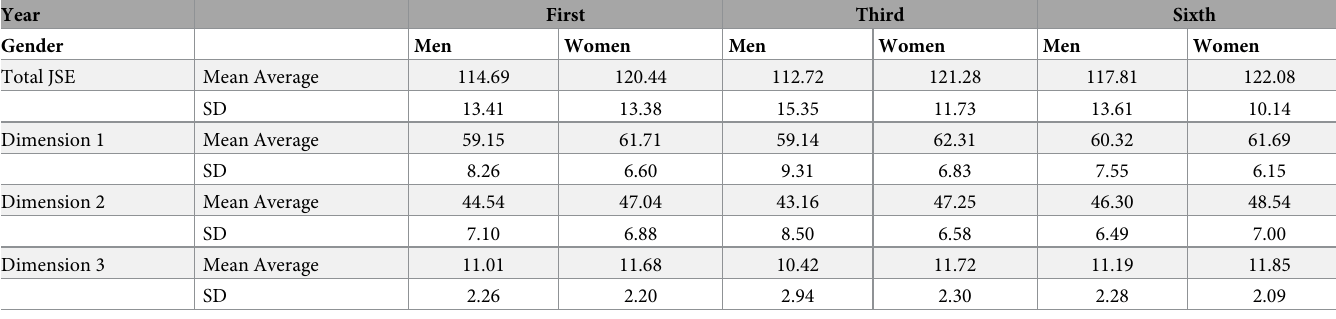
Table 3. Jefferson Scale of Empathy (JSE) scores by academic year and gender from the sample of 2,268 medical students from